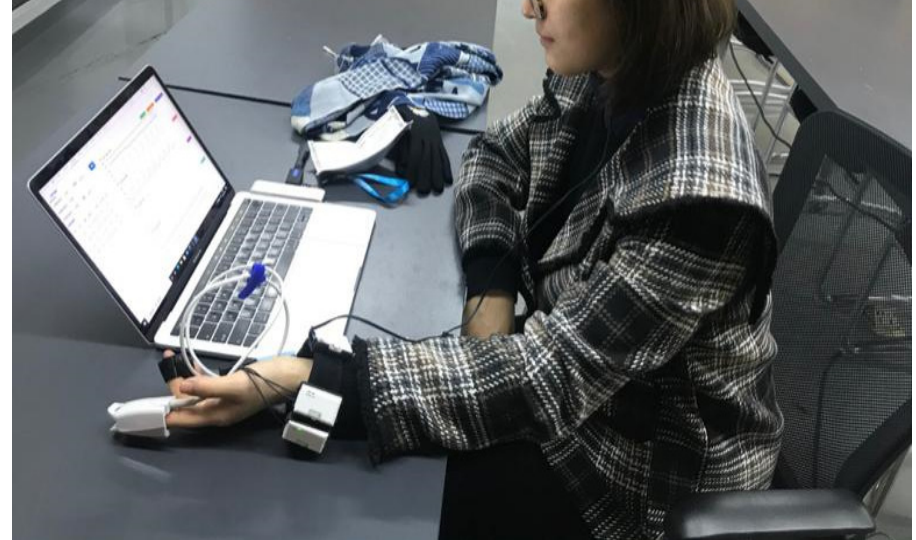
Figure 9. The participant sat still and waited for fluctuations of the physiological experimental data to stabilize.